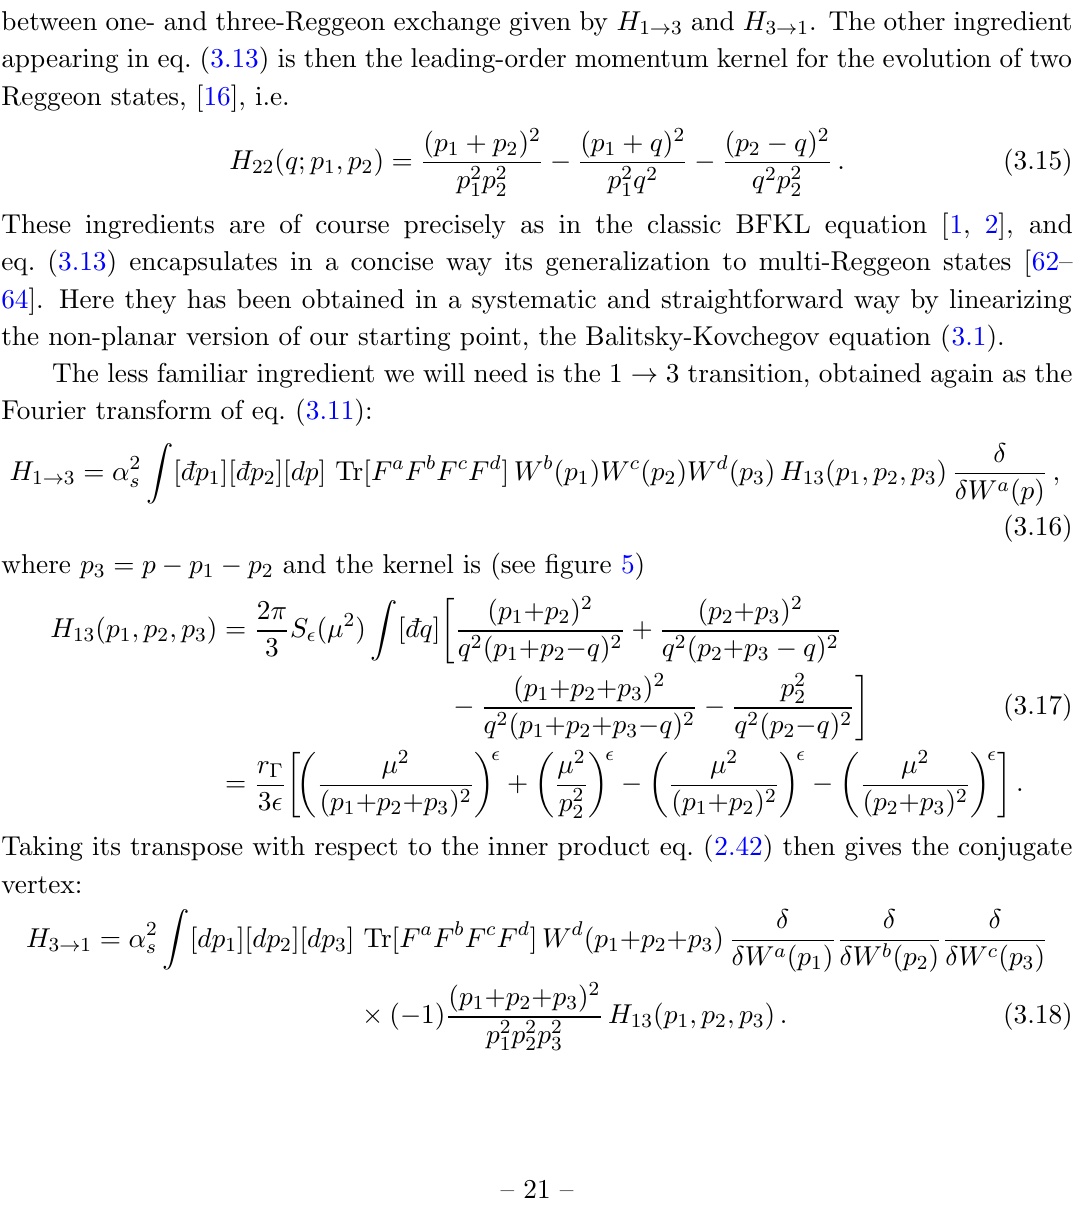
2 (cid:15) dimensions, therefore the vertices indicated by black dots must (cid:0)